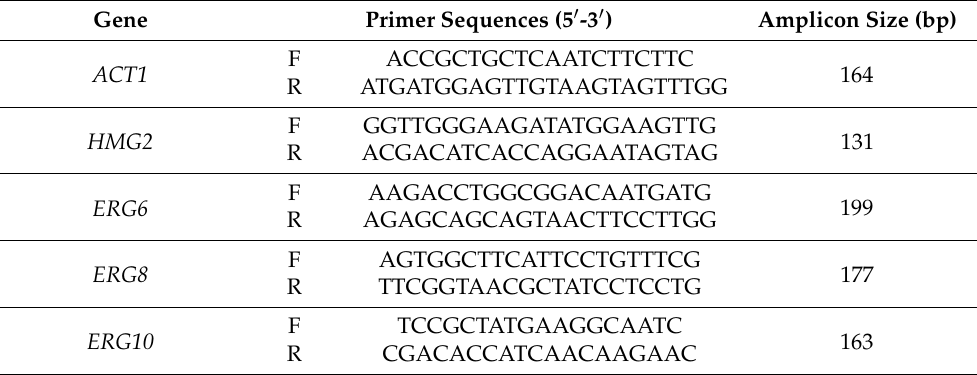
Table 1. Primer pairs used for quantitative real-time